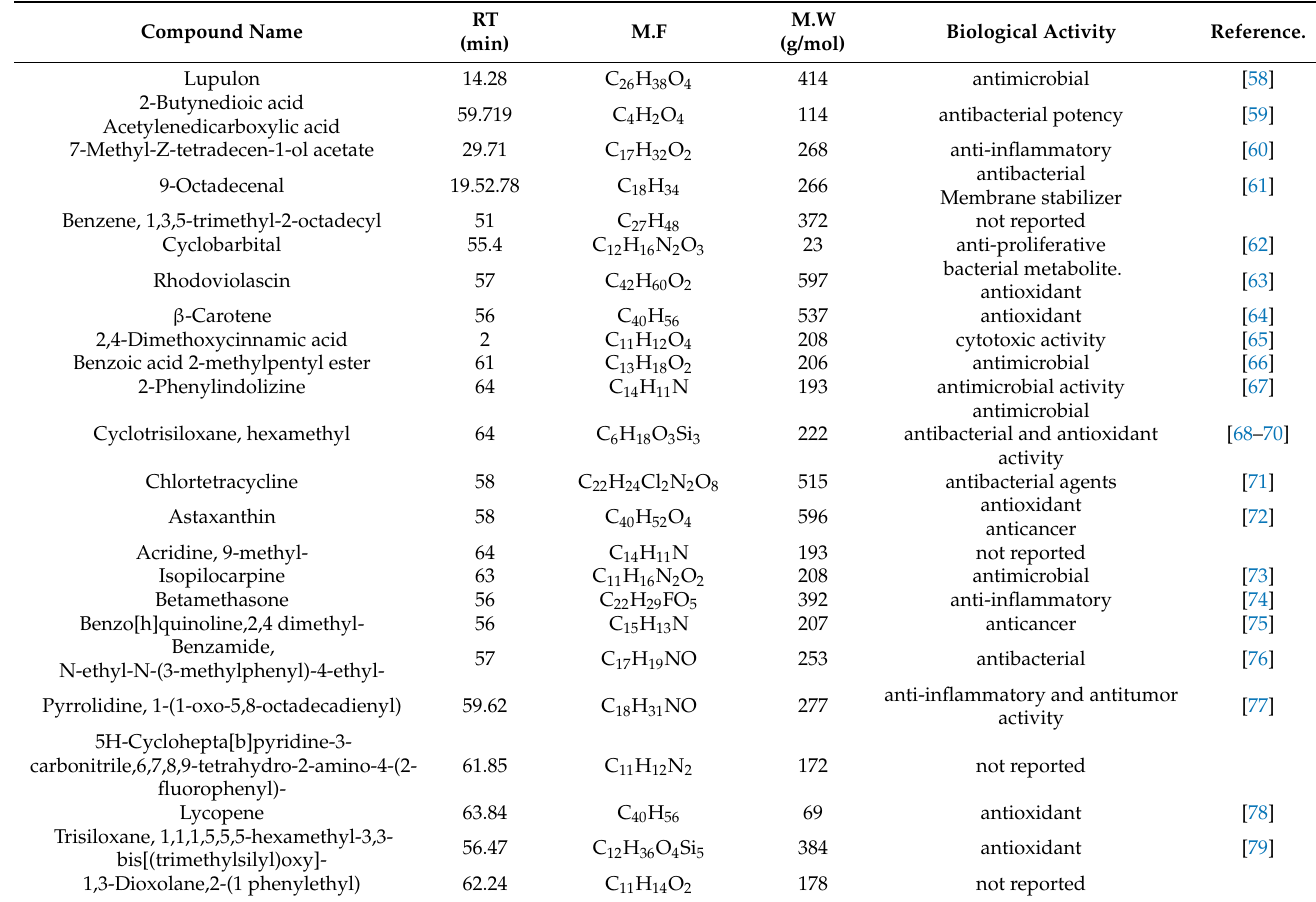
Table 7. List of compounds of ASG ethanolic extracts observed in GC-TOFMS with their retention time and biological